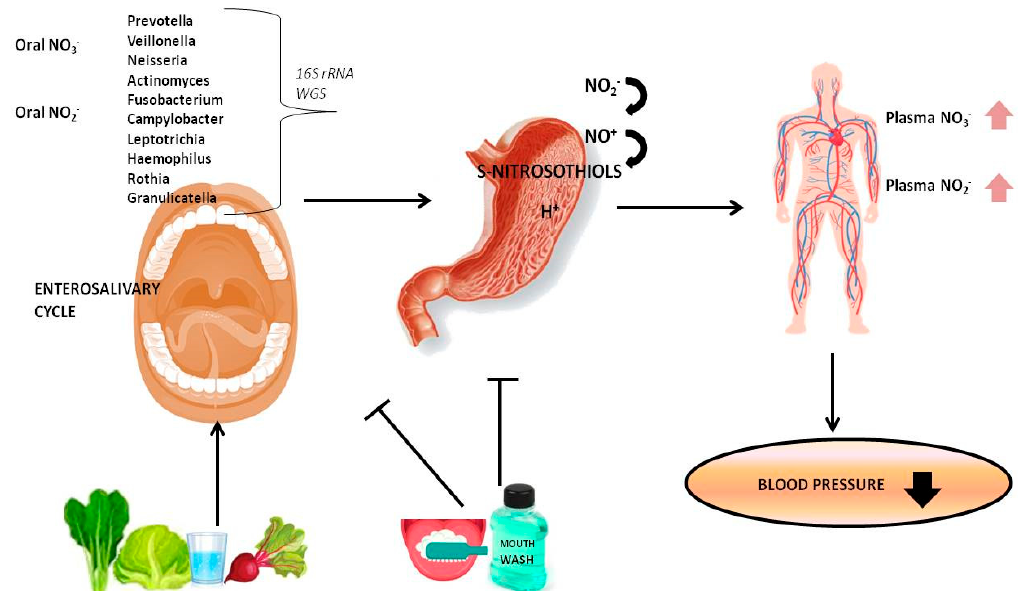
Figure 1. Interplay between dietary nitrate and oral commensal bacteria in the enterosalivary circulation of nitrate and in blood pressure. In the figure, the most reported abundant nitrate-reducing bacteria are listed, detected both by Sanger 16S rRNA sequencing and by whole genome sequencing (WGS). By the shotgun WGS, a method that sequences all genes rather than the more targeted approach of 16S rRNA sequencing, a greater number of bacterial species have been identified (see main text). The increase in nitrates and nitrites in the plasma has the effect of dilating the capacity of the arteries and consequently lowering blood pressure. Dietary nitrate and oral reducing bacteria contribute to nitrate reduction and circulating nitrous oxide. On the contrary, the daily use of an antiseptic mouthwash and tongue cleaning prevents the reduction of nitrate to nitrite and disrupts the enterosalivary cycle by affecting oral concentrations of commensal reducing bacteria. Therefore, nitrite does not achieve the acidic environment of the gastric cavity thus decreasing the S-nitrosothiols formation.